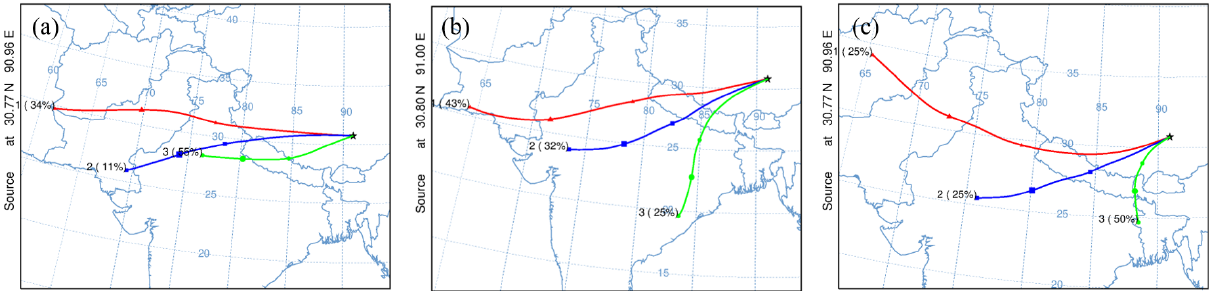
Figure 5. The frequencies of the 48h back trajectories of air masses arriving at the Nam Co station from different directions during the occurrence time of nucleation (11:00–18:00) in (a) non-event days, (b) NPF-pre days and (c) NPF-monsoon days.